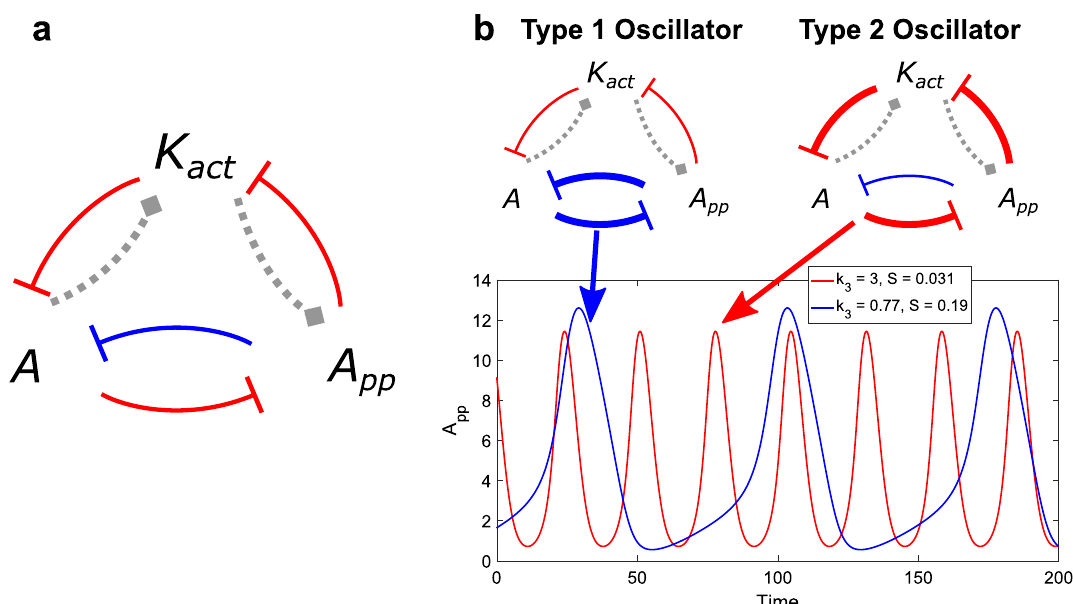
Figure 8. Network of the feedbacks between the variables K act , A and A pp of the reduced Suwanmajo-Krishnan signaling motif. ( a ) In red, the three negative interactions that constitute the negative feedback loop. The blue and red interactions between A and A pp make up the positive feedback loop. In grey, the interactions than can be either positive or negative. ( b ) The two possible types of oscillator, depending on the relative strength between the feedbacks. This strength is modulated by the biochemical parameters. For example, when k 3 is relatively low, the oscillations will be of the relaxation-type (bold blue for the positive feedback loop, blue time series). When k 3 is high, the output will be smooth and symmetrical (bold red for the negative feedback loop, red time